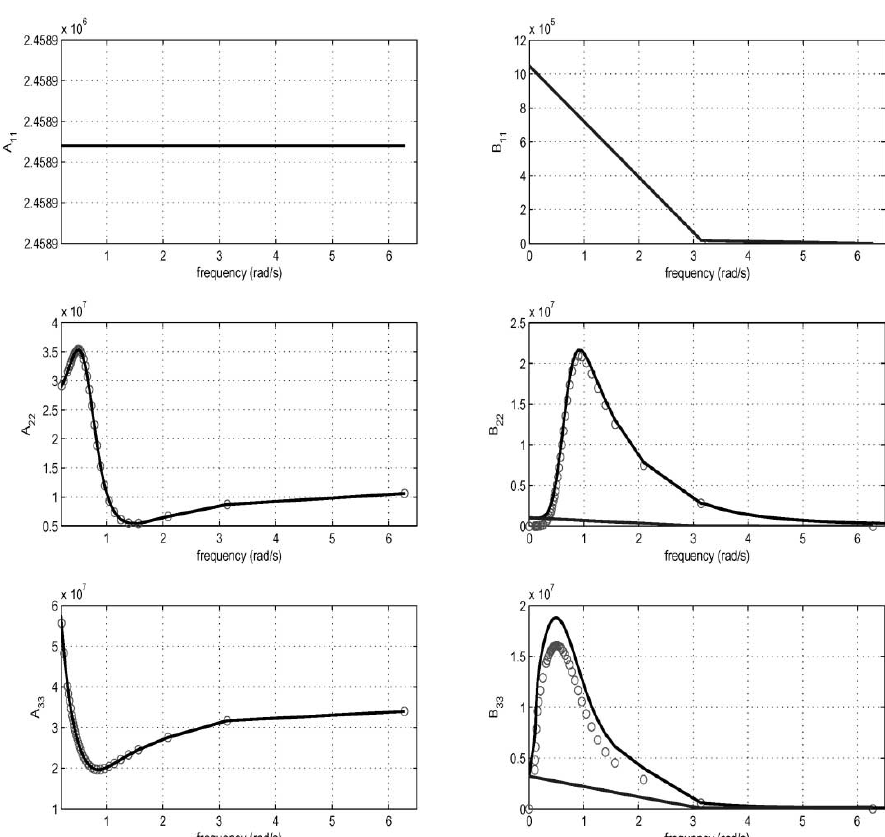
Figure 8. Frequency dependent added mass A B for the S-175 container ship. Circles indicates VERES data points while the solid line is 33 due to interpolation. For the B addition a viscous ramp function is added to the B mass is chosen as 10% of the mass while B